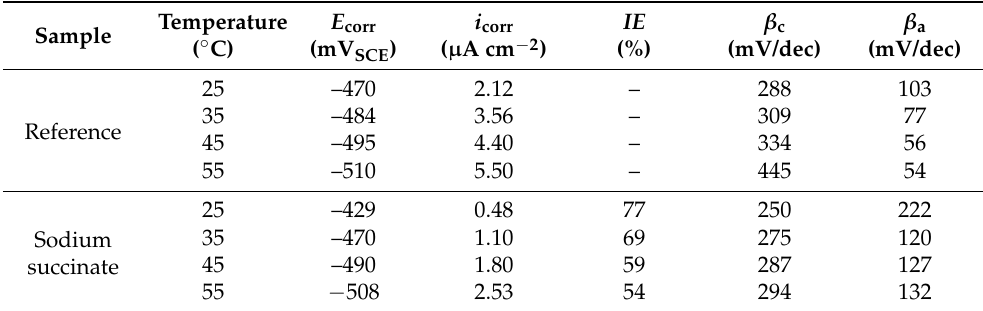
Table 1. PDP curves electrochemical parameters of carbon steel in 0.6 M Cl − SCPS in the absence and presence of 0.6 M sodium succinate at 25, 35, 45, and 55 ◦ C.